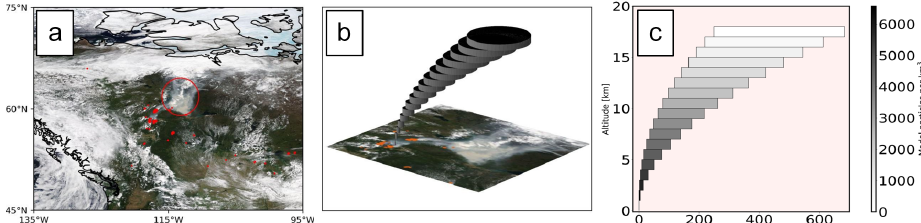
Figure 1. (a) MODIS Terra true colour reflectance tile for 17 June 2019 with thermal anomalies overlaid in red. Emissions from forest fires can be seen as a brownish grey cloud (circled in red). (b) Conceptual diagram of NAME source term used to initialise BBA dispersion simulation. (c) Profile of source term showing the concentration of model particles in each cylinder. Within each cylinder an arbitrary mass of 0.1Tg was released over 100000 model particles uniformly distributed through the volume of each